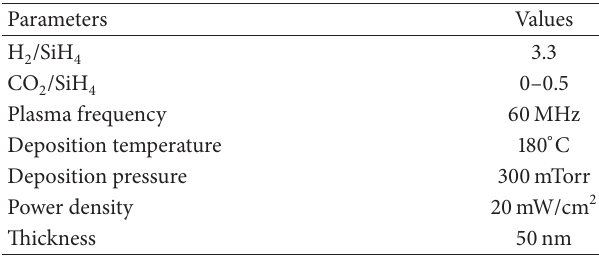
Table 1: Deposition conditions for the i-a-SiO:H films.